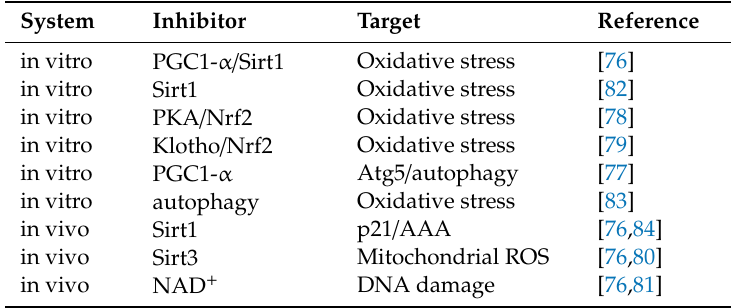
Table 2. Inhibitors of AngII-dependent senescence in